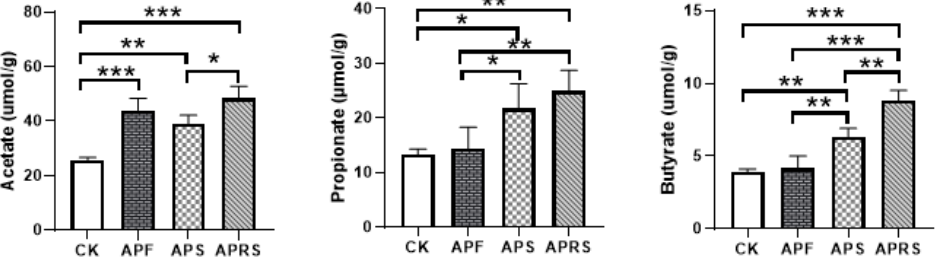
Figure 5. Concentration differences of acetate, propionate, and butyrate in fecal samples (* p < 0.05, ** p < 0.01, *** p < 0.001, one-way ANOVA with LSD test).